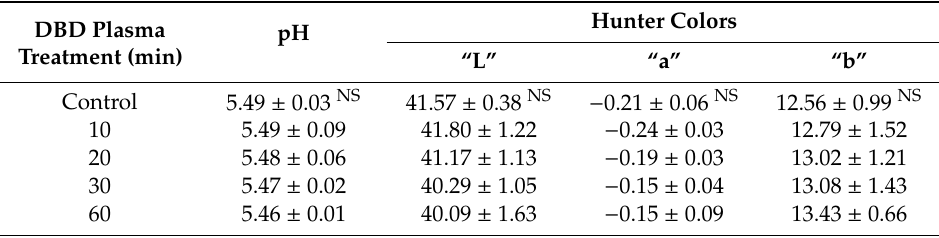
Table 3. Changes in pH and Hunter colors when using DBD plasma treatment in